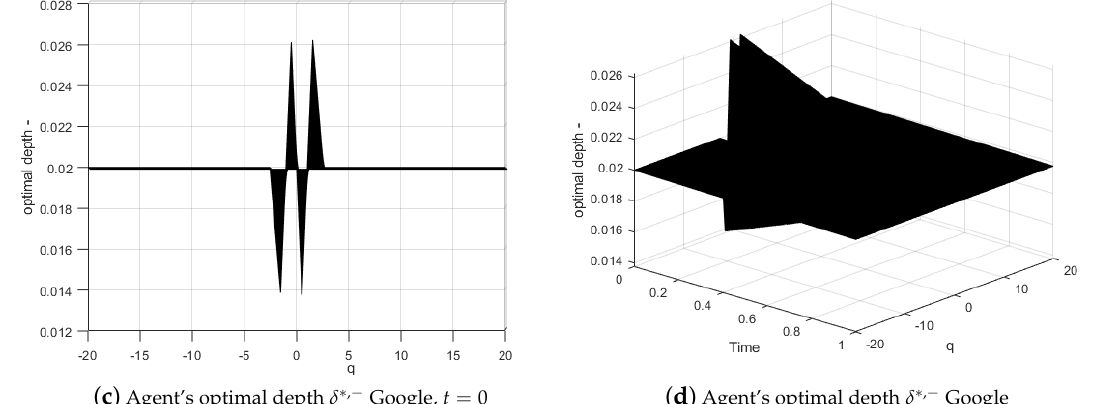
Figure 10. Agent’s optimal depth for selling LOs and agent’s optimal depth for buying LOs for Google stocks. ( a ) agent’s optimal depth calculated with Equation (94), using the parameters in Table 10 at time zero. ( b ) agent’s optimal depth calculated with Equation (94), using the parameters in Table 10 in 3 dimensions. ( c ) agent’s optimal depth calculated with Equation (95), using the parameters in Table 10 at time zero. ( d ) agent’s optimal depth calculated with Equation (95), using the parameters in Table 10 in 3